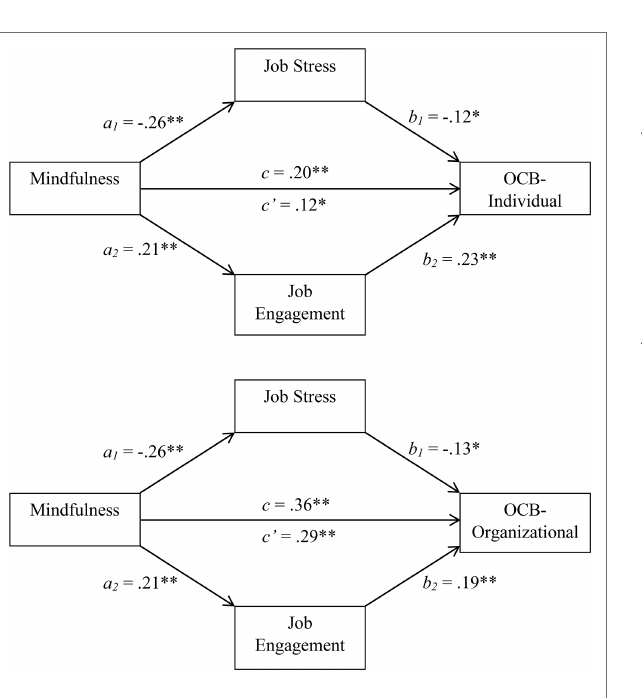
FIGURE 2 | Job stress and job engagement as mediators of the relationship between mindfulness and citizenship behaviors directed toward individuals ( top panel ) and the organization ( bottom panel ), Study